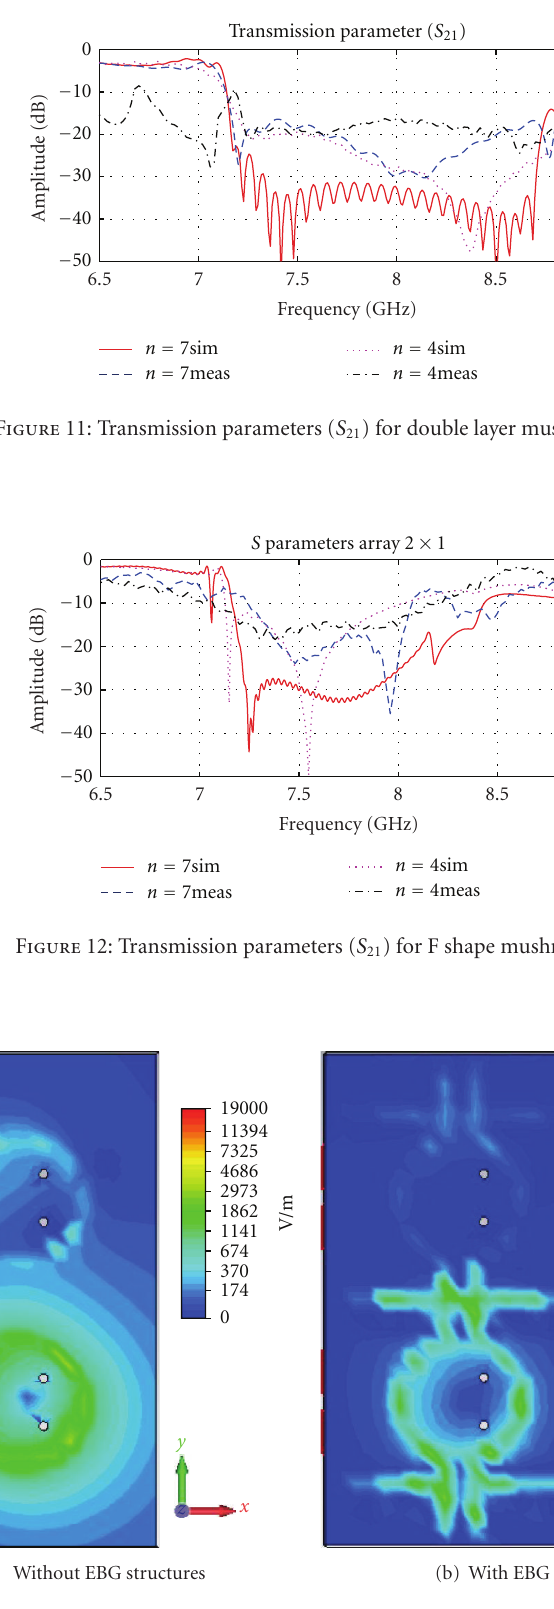
Figure 13: | E | field simulation of two round patches with dual circular